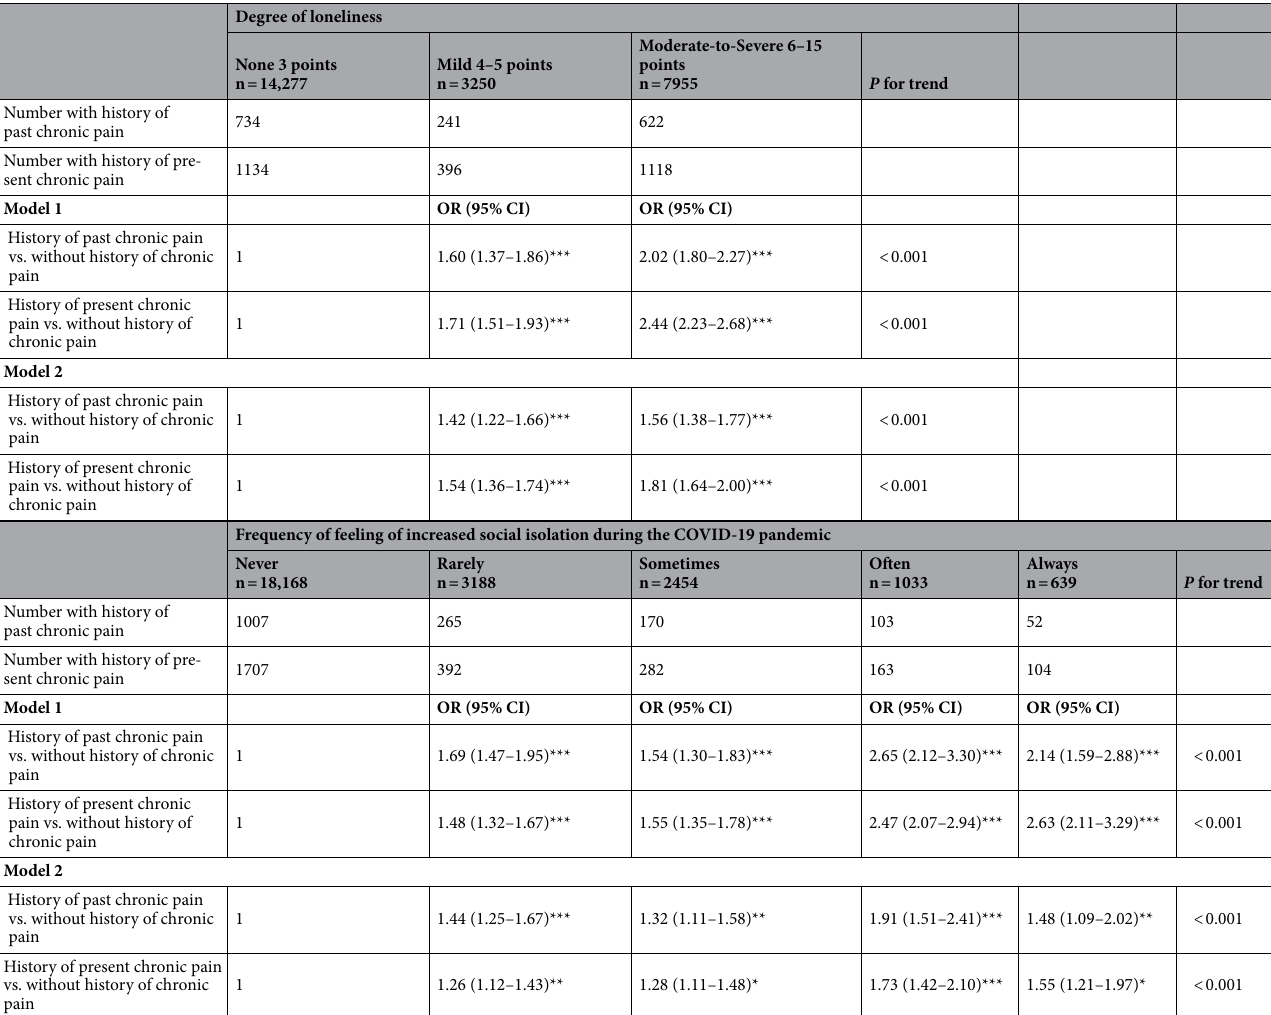
Table 4. The association of loneliness and a feeling of increased social isolation with a history of past and present chronic pain during the COVID-19 pandemic. Model 1: Adjusted for age and sex. Model 2: Adjusted for age, sex, educational level, marital status, living alone, employment status, equivalized income, smoking status, alcohol consumption, physical activity, sleep duration, history of depression, and history of mental illnesses other than depression. COVID‑19 coronavirus disease 2019, OR odds ratio, CI confidence interval. Loneliness was measured using the Japanese version of the University of California, Los Angeles Loneliness Scale (Version 3), Short Form 3-item assessment tool. For loneliness, P values were calculated to compare participants without loneliness to those in the other categories by multinomial logistic regression. For social isolation, P values were calculated to compare participants who did not feel increased social isolation during the COVID-19 pandemic at all to those in the other categories by multinomial logistic regression. * p < 0.05, ** p < 0.01, *** p < 0.001. n =